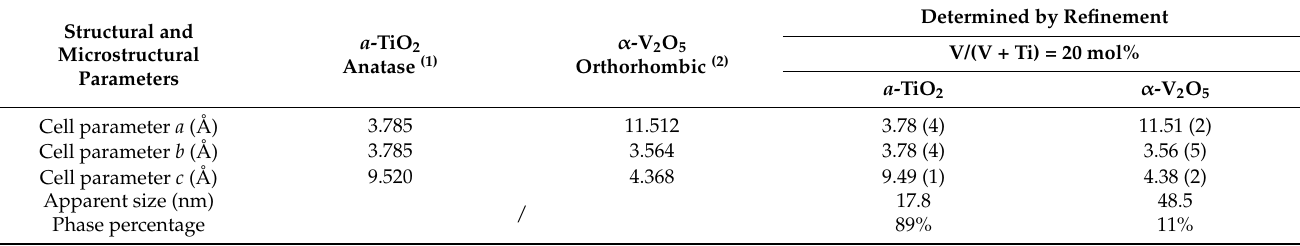
Table 2. Rietveld analysis of V-TiO 2 nanopowder with 20 mol% V calcinated at 450 ◦